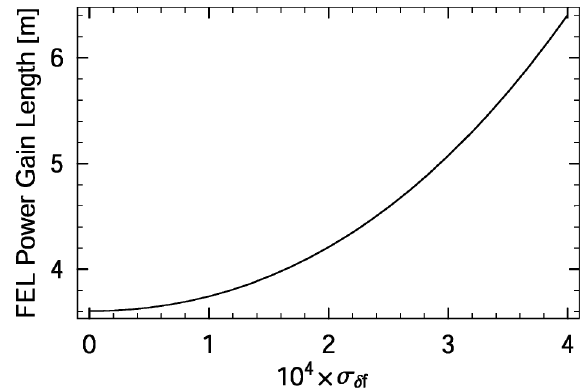
FIG. 5. Microbunching gain after BC2 as a function of the initial modulation wavelength (cid:5) curve) and on (dashed curve).